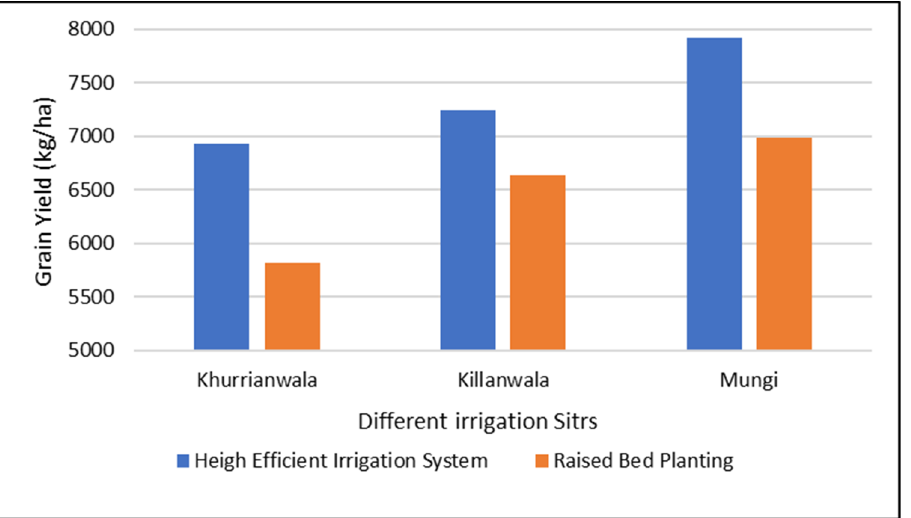
Figure 6. Comparison of grain yield (kg/ha) of maize, sown at different sites [15].